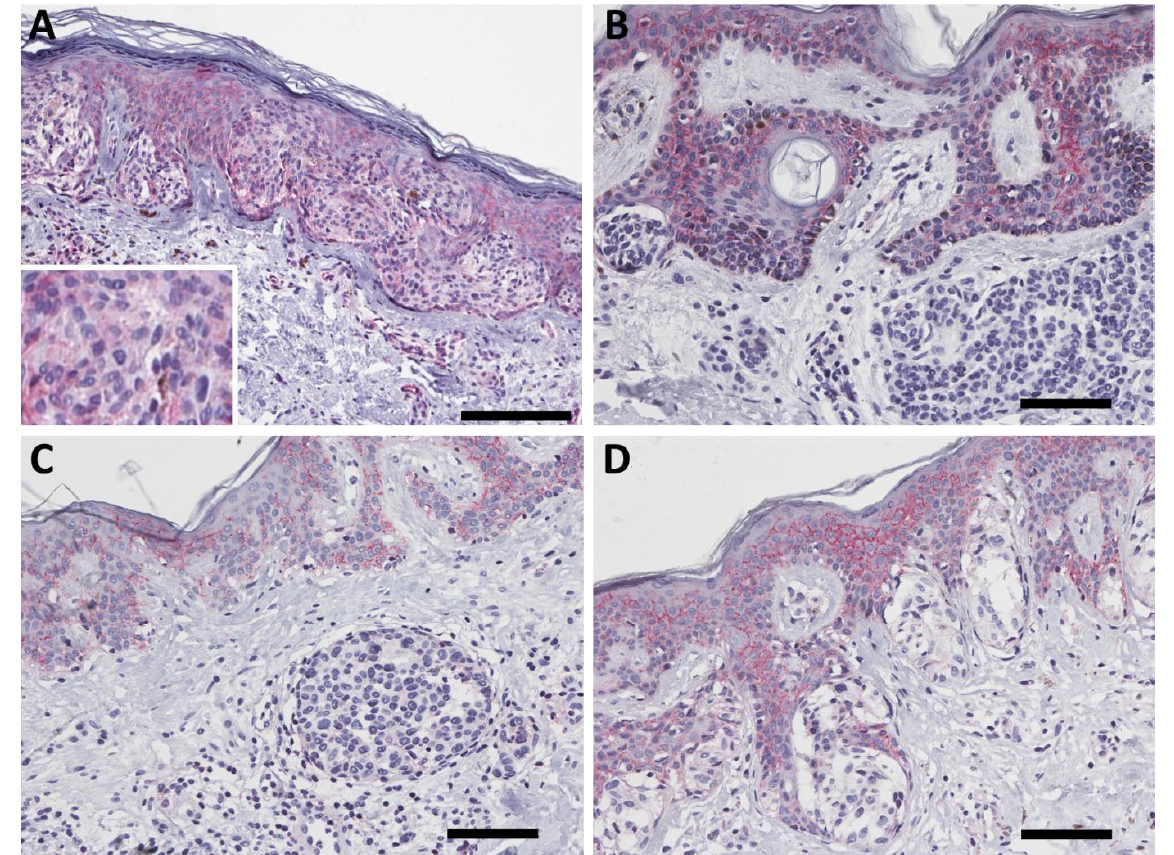
Figure 2. PMCA4b expression in human nevus. No plasma membrane specific staining was observed in any of the nevi ( A — junctional, B — compound, C — intradermal and D — dysplastic). in any of the nevi ( A —junctional, B —compound, C —intradermal and D —dysplastic). Scale bars: Scale bars: A 100; µm; B-D: 50 µm. ( A ) 100; µ m; ( B – D ): 50 µ